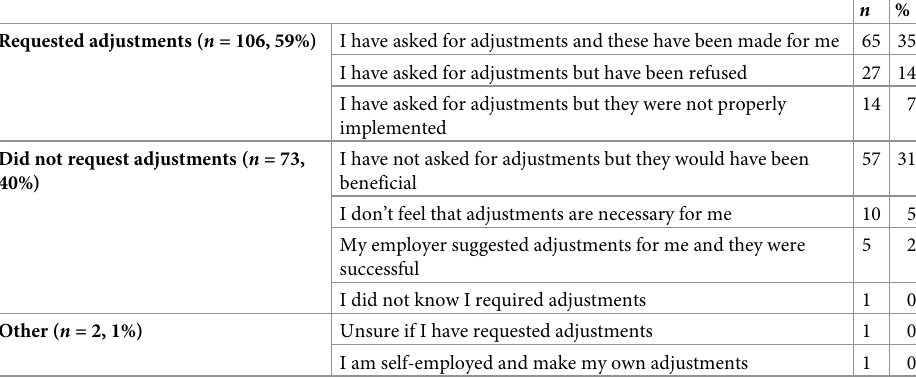
Table 2. Participants’ experiences of requesting adjustments ( n = 181).